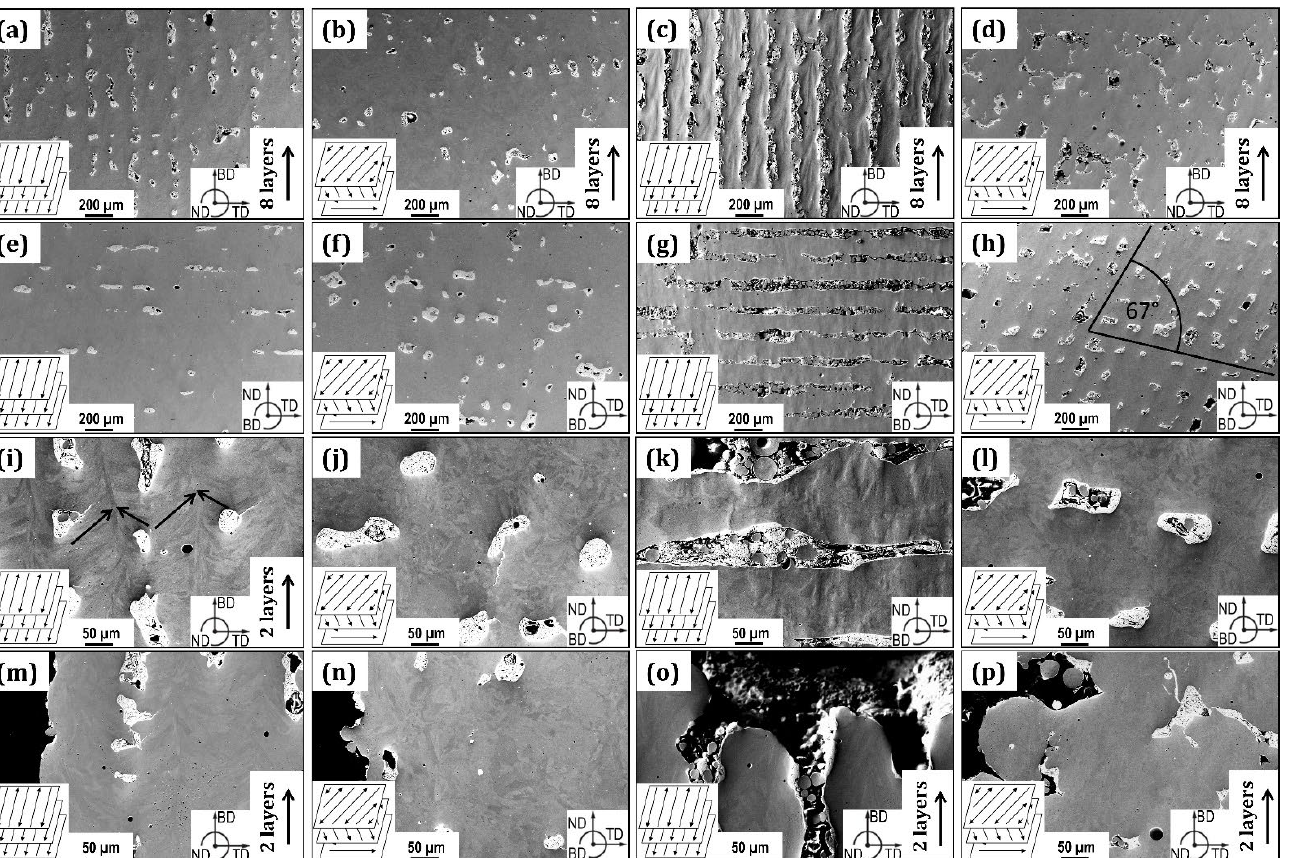
Figure 4. SEM-SE: morphology of AgCaLa phases in a FeMn matrix: ( a , e , i , m ) HD-0, AgCaLa phases positioned between adjacent melt pools; ( b , f , j , n ) HD, homogeneously distributed AgCaLa phases; ( c , g , k , o ) LD-0, distinctive deposition of AgCaLa phases between adjacent melt tracks with a weak connection between single tracks; ( d , h , l , p ) LD, AgCaLa phases aligned along the melt tracks, separated by the deep center of the melt pool of the following layer.